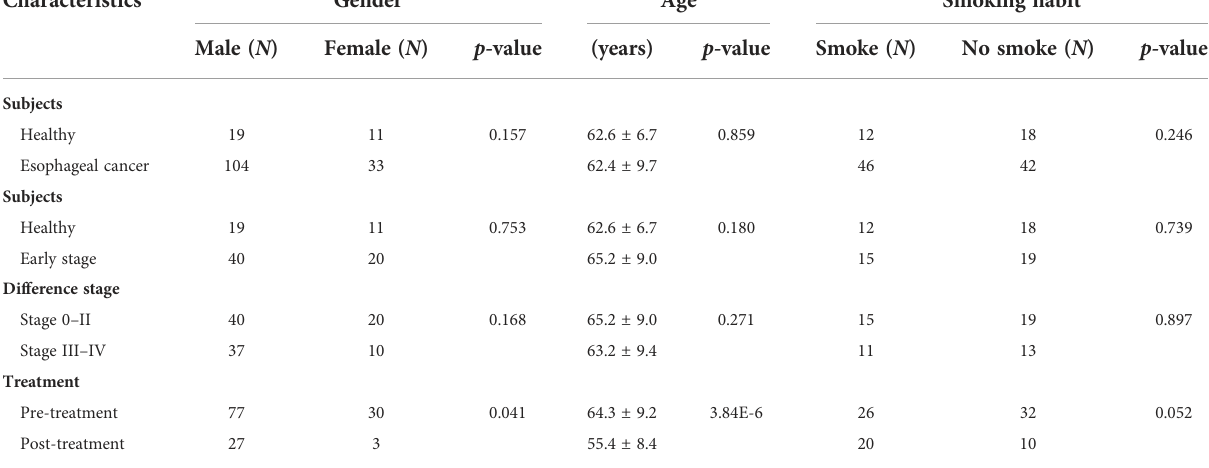
TABLE 1 Characteristics of subjects.